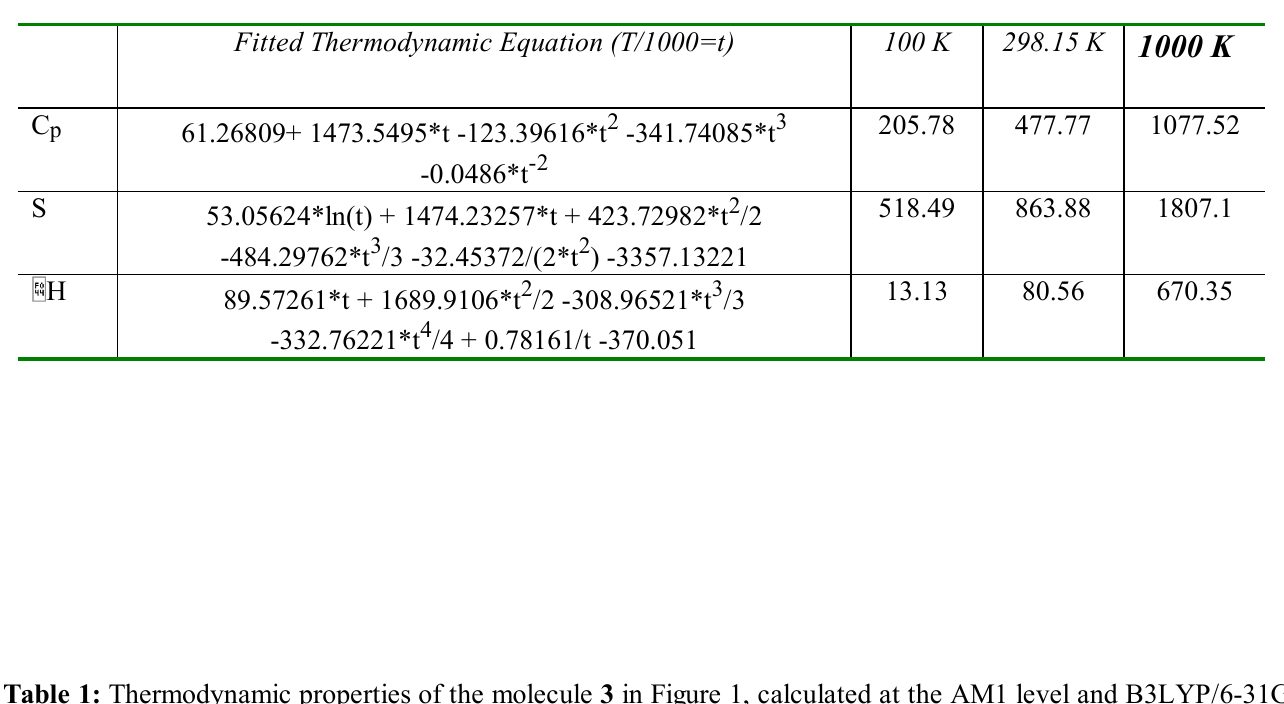
Table 1: Thermodynamic properties of the molecule 3 in Figure 1, calculated at the AM1 level and B3LYP/6-31G* level of theory, where C p is the heat capacity in J mol -1 K -1 , S is the entropy in J mol -1 K -1 , and ∆H is the standard enthalpy kJ mol -1 . These where fitted to the Shomate equations which are implemented by the JANAF tables of the NIST